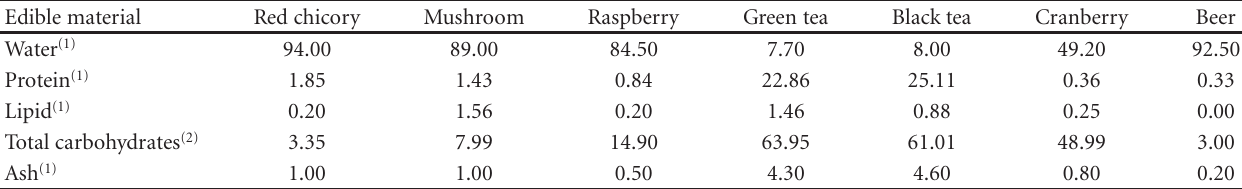
Table 1: Water, macronutrients, and ash content of the selected food/beverages (g/100g edible material).